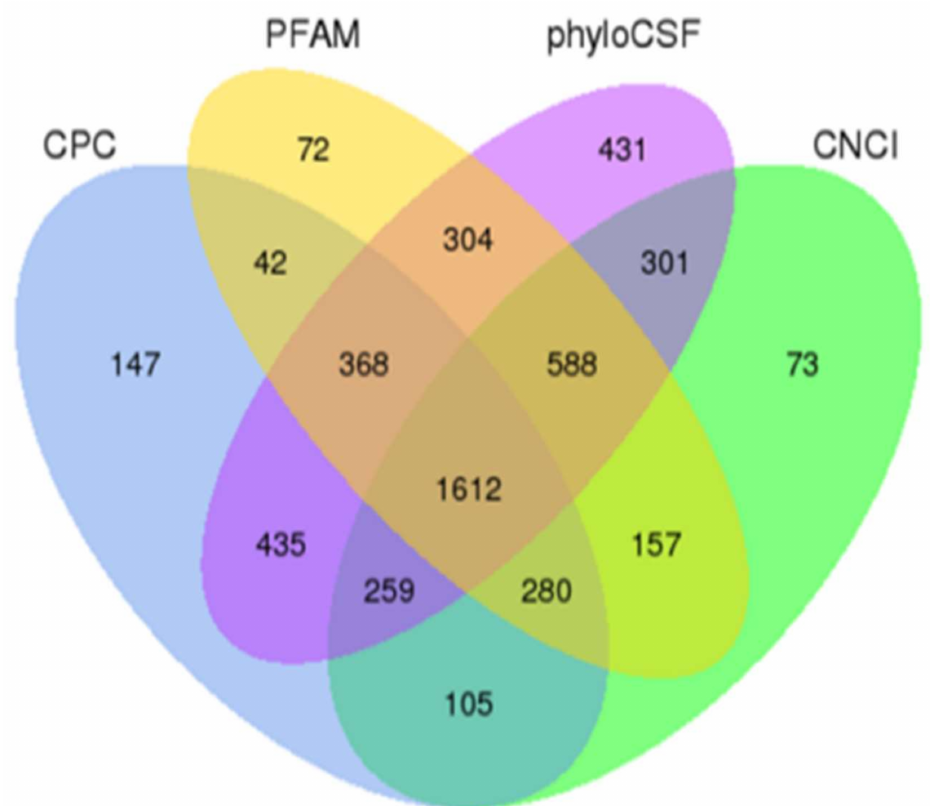
Figure 1. Screening and classification of the candidate lncRNAs in the intestine transcriptome of piglets. Venn diagram illustrating the coding potential analysis by four different tools including CNCI, CPC, Pfam-scan, and